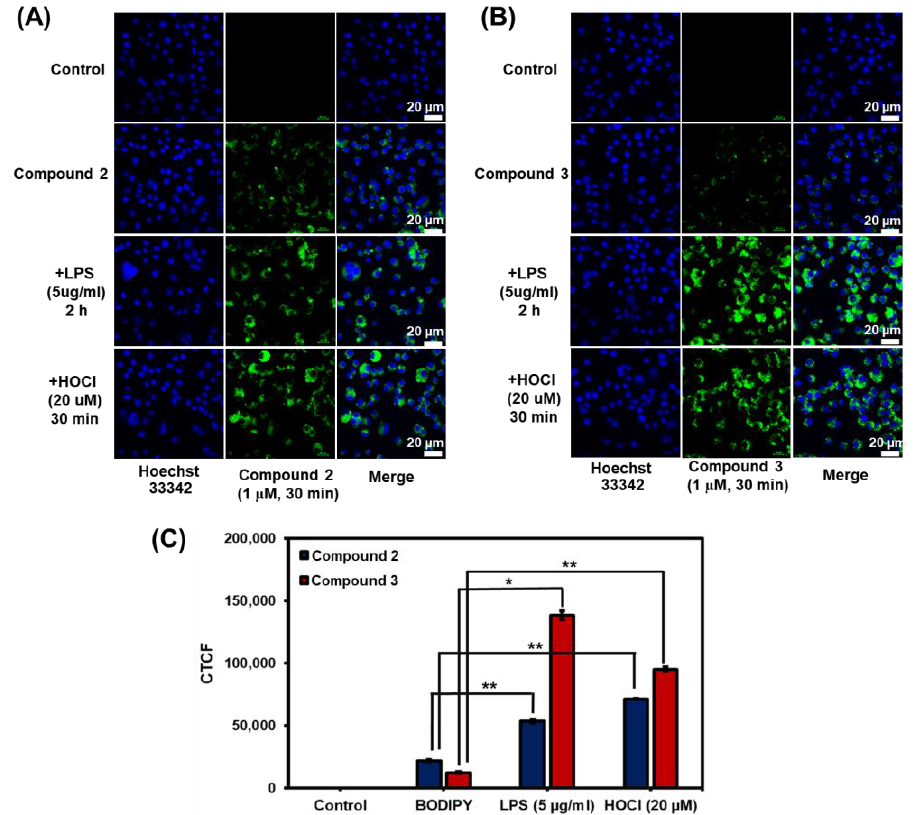
Figure 8. Fluorescence images of compounds 2 and 3 in RAW264.7 cells: ( A ) fluorescence images of compounds 2 and ( B ) compound 3 . For the imaging of endogenous HOCl, RAW 264.7 cells were incubated with 1 μM of the probes for 30 min and then 5 μg /mL of LPS for another 2 h. For the imaging of exogenous HOCl, RAW 264.7 cells were stained with 1 μ M of the probes for 30 min and then NaOCl (20 µM) for another 30 min. The images were obtained using a laser scanning confocal microscope (Nikon A1Rsi, 63× oil immersed optics). Scale bar = 20; ( C ) Quantitative corrected total cell fluorescence (CTCF) data, which were quantified using ImageJ and represent the mean ± SD ( n = 30). Statistical analysis is based on T-test (* p < 0.05, ** p < 0.01, *** p < 0.001).